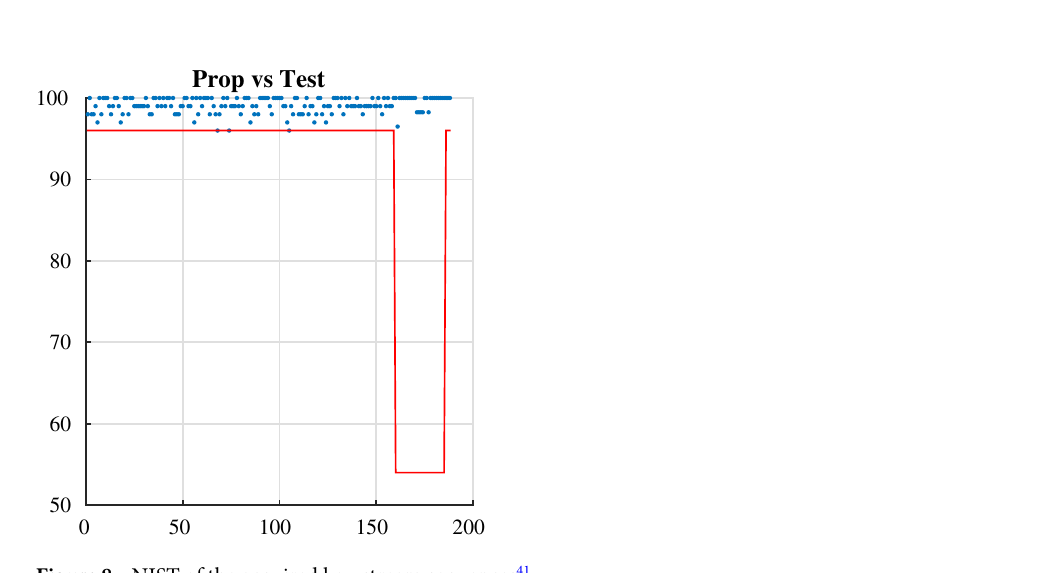
Figure 8. NIST of the acquired key-stream sequences 41